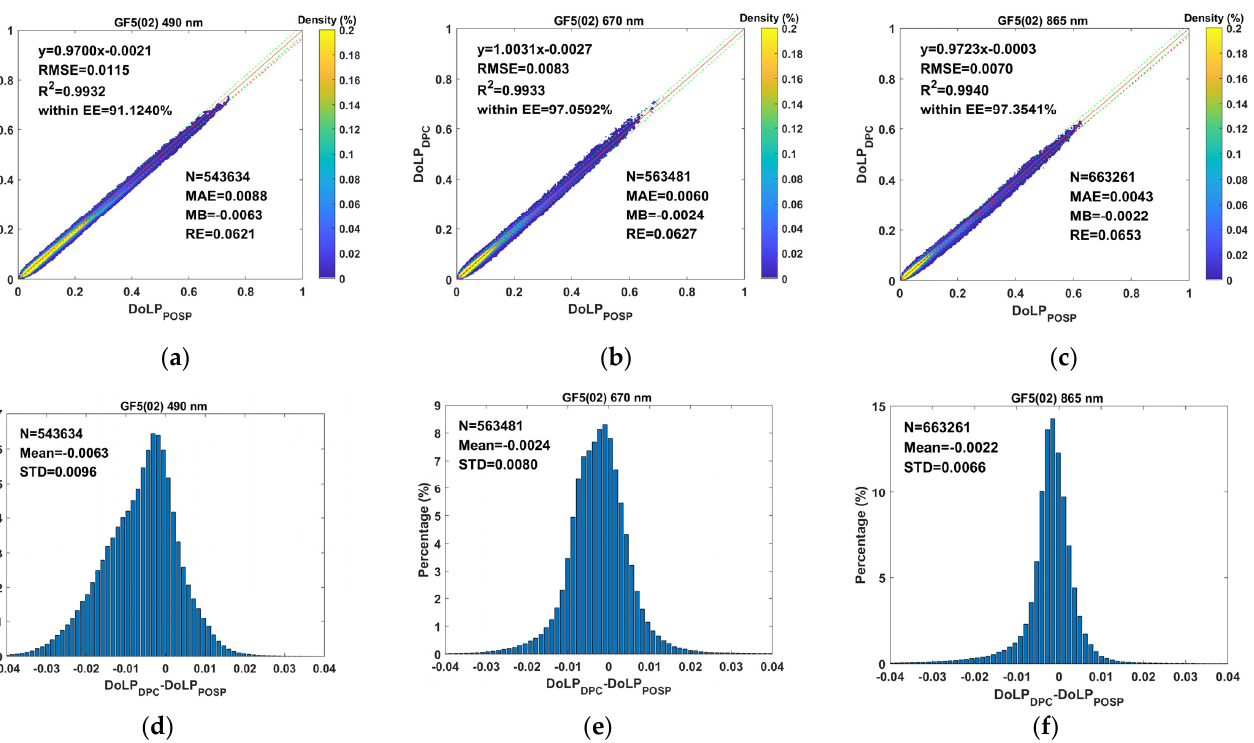
Figure 11. The ratio of DPC to POSP normalized radiance in the 670 nm band with different VZAs. These data pairs are selected for collection from ( a ) November 2021; ( b ) December 2021; ( c ) January 2022; ( d ) February 2022; ( e ) April 2022; and ( f ) May 2022 in DPC and POSP Level 1 products.